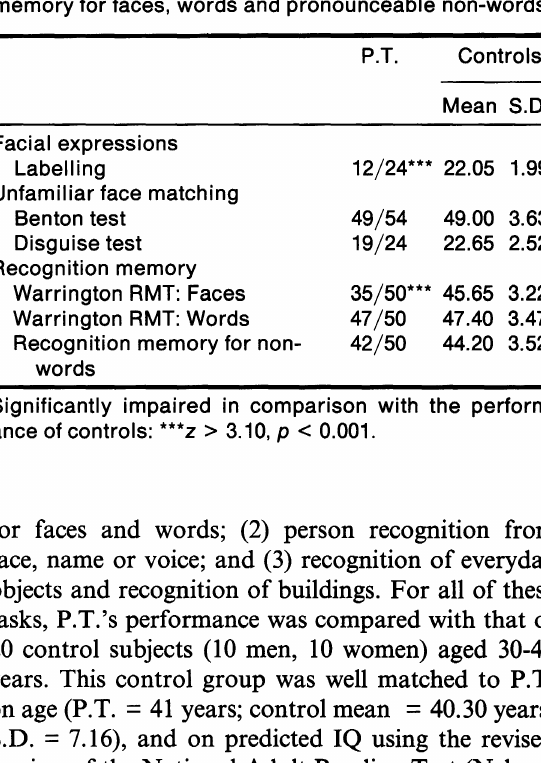
TABLE I. P.T.'s performance on tests of facial expression labelling, unfamiliar face matching, and recognition memory for faces, words and pronounceable